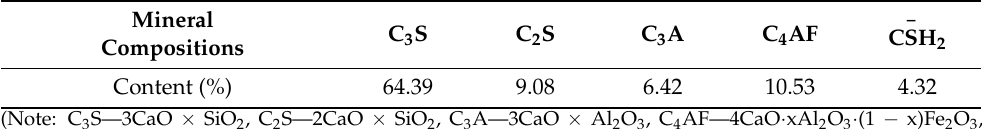
Table 2. Mineral composition of